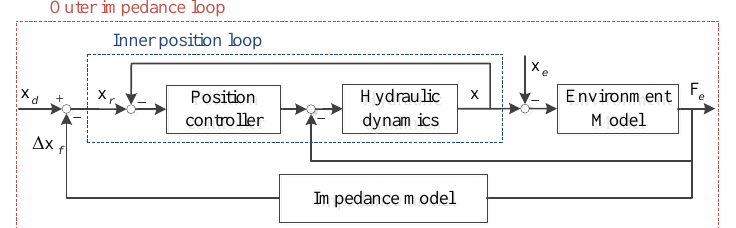
Figure 6. The diagram of position/force based active compliance controller.